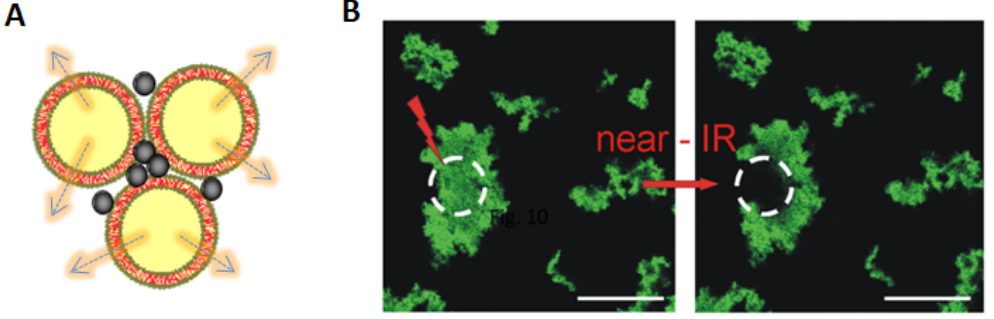
Figure 8. ( A ) Scheme of a complex of liposomes with gold nanoparticles (either single or nanoparticle aggregates). Liposome cargo is released if the temperature is above the lipid phase transition temperature; and ( B ) CLSM fluorescence images before and after illumination of a complex of CF-filed liposome with gold nanoparticles. The scale bar is 10 µm. (Adapted with permission from [108]. Copyright 2009 John Wiley and Sons).